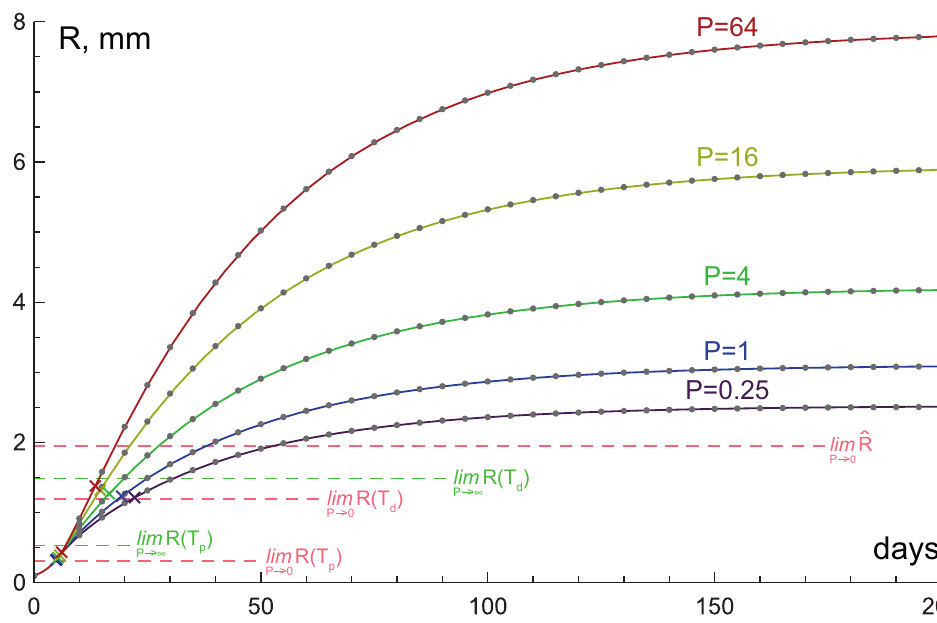
Figure 5. Tumor growth curves, produced by system of Equation (7) for different nutrient supply levels P , obtained by semi-analytical methodology (solid lines) and by numerical simulations (gray dots). Multicolored crosses denote the moments when glucose concentration in tumor center equals g p , below which tumor cells turn to quiescent state, and g d , below which tumor cells die. The denoted limit values for tumor radius under infinitesimal and infinitely large values of P are defined by Equations (11) and (15), except for lim P → 0 ˆ R , which is estimated numerically, as well as lim P → ∞ ˆ R ≈ 11.34 mm, which is not